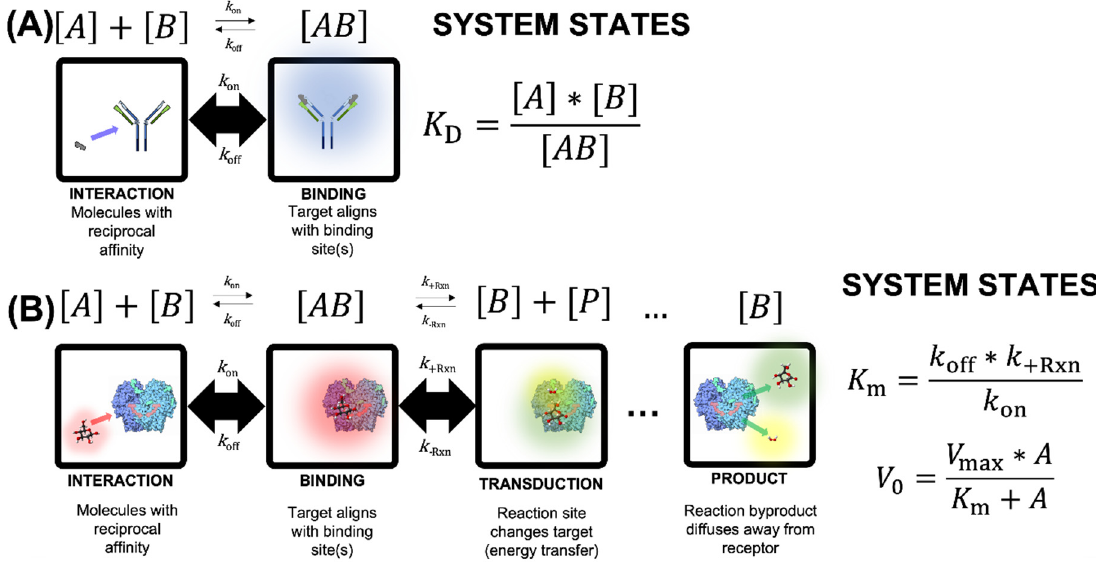
Figure 3. Symbolic and particulate schematics for ( A ) binding (top) and ( B ) binding + reaction (bot- tom). Although the derivation of the two model systems uses a similar approach, the mathematical underpinnings are quite different, and derivation is based on mutually exclusive assumptions. In panel A, the particulate representation uses a generic monomer as receptor (ligand) and truncated epitope (target). Binding (complex formation) is represented as the blue halo. In panel B, the partic- ulate representation depicts oxidation of β -D-glucose (red halo) to gluconolactone (green halo) and hydrogen peroxide (yellow halo) by the enzyme glucose oxidase (Gox), oxygen (O 2 ) is not shown. 3D structure is available in the Protein Data Base (PDB), according to Wohlfahrtet et al. [27] and Sehnal et al. [28].